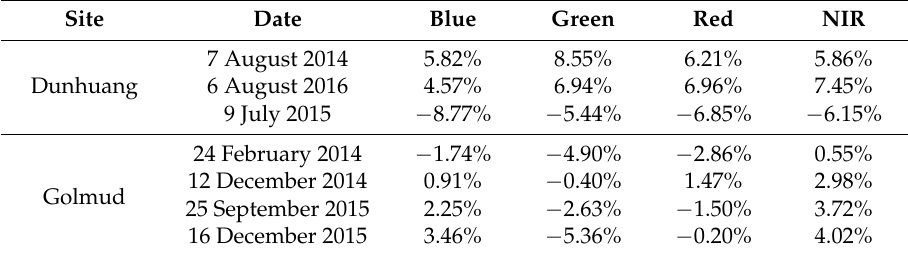
Table 12. The relative errors of cross-calibration coefficients between the two reference